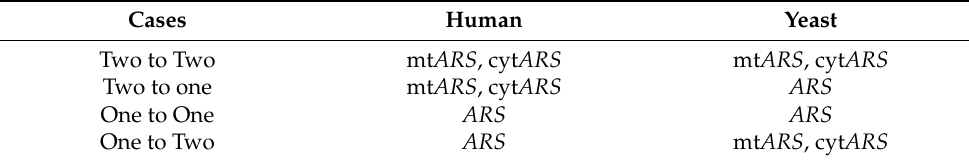
Table 1. ARS encoding genes in human and yeast. In both organisms, a unique gene ( ARS ) or two specific genes encode for the mitochondrial and cytoplasmatic aminoacyl-tRNA synthetase isoforms, (mtARS and cytARS, respectively). The different combinations can be clustered in 4 different cases. Cases Human Yeast Two to Two mt ARS , cyt ARS mt ARS , cyt ARS Two to one mt ARS , cyt ARS ARS One to One ARS ARS One to Two ARS mt ARS , cyt